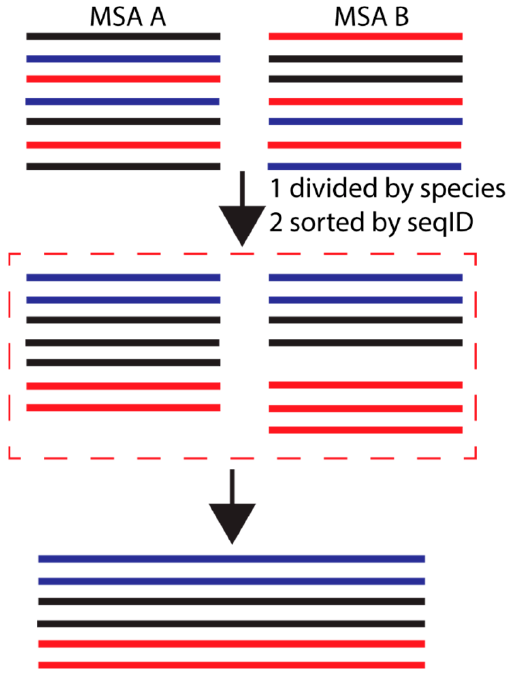
Figure 6. The flowchart of the phylogeny information-based method. Stage 3. The main points of the process (according to the protein interaction network to build cpxMSA) are as follows: (i) Download the protein interaction information